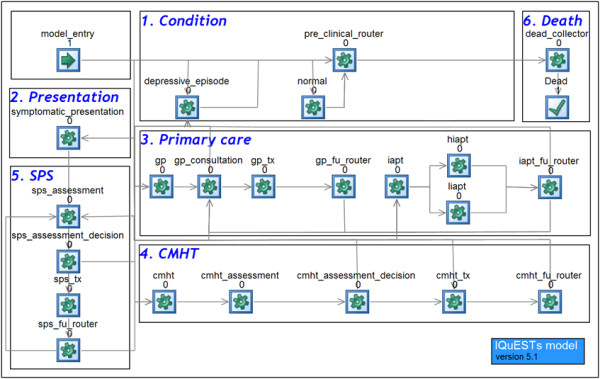
Simulation model.